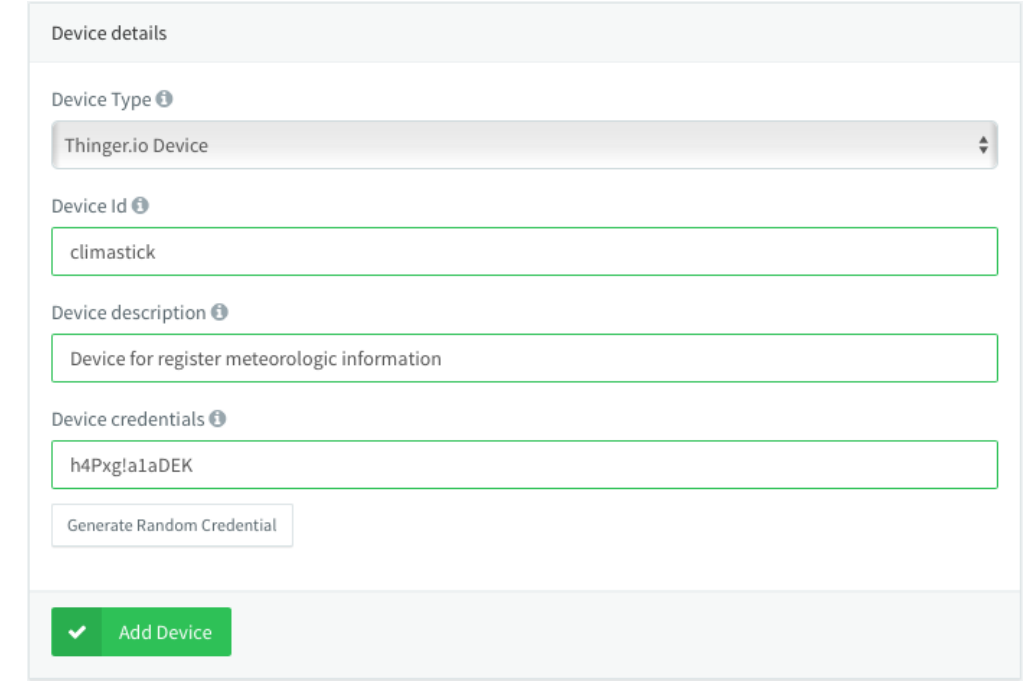
Figure 19. Adding a device in